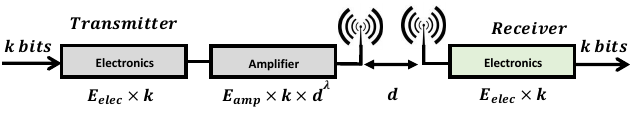
Figure 8. First order radio